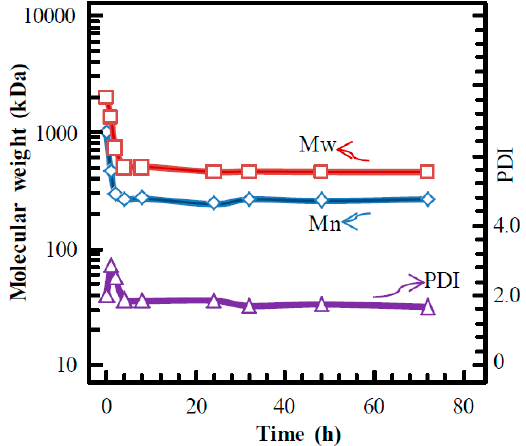
Figure 6. Molecular weight ( M w and M n ) and polydispersity index (PDI) of the residual PVDF– g –St films with different extraction times. The data were calculated from Figure 5 using standard polystyrene for calibration curve. Eluent, 10 mM LiBr in DMF; flow rate, 1.0 mL/min; column temperature, 40 ° C; UV detector (270 nm).